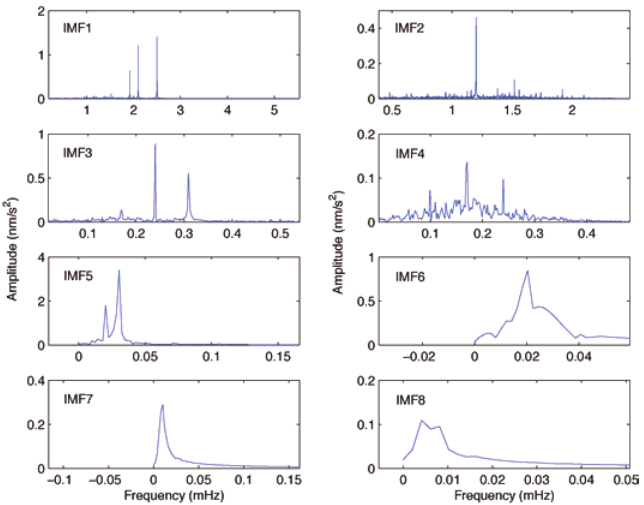
Figure 1. (c) Fourier amplitude spectra for the corresponding IMF1-8, demonstrating that each IMF in Figure 1a indeed contains certain frequencies, as can be seen from Figure 1b. Therefore certain IMFs can be selected to study the signal of